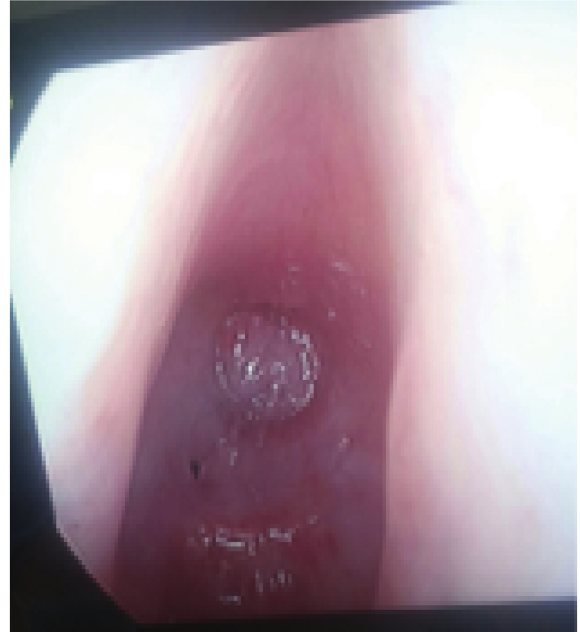
Figure 4: Grade III membranous subglottic stenosis with only a pinpoint opening as seen on endoscopic examination.